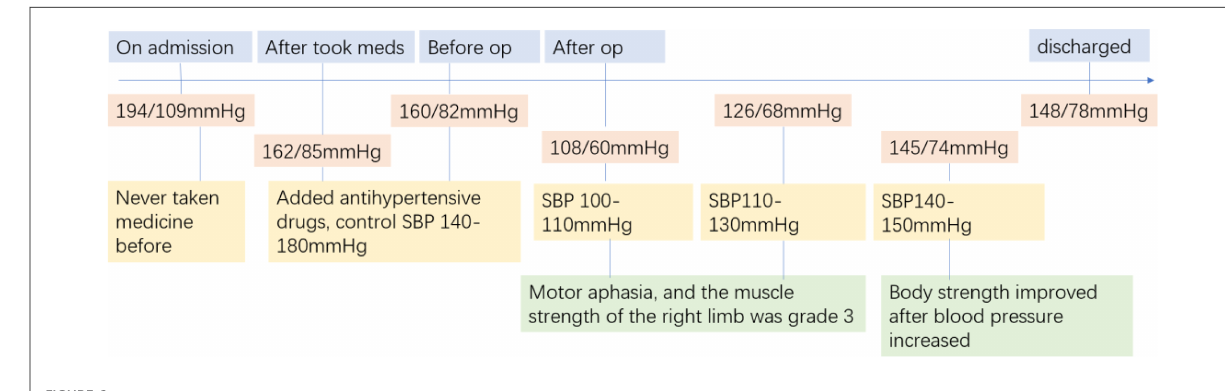
FIGURE 6 Timeline with relevant blood pressure